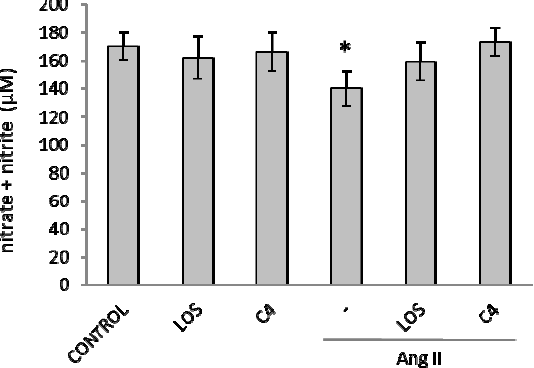
or with Ang II 5000 nM plus LOS or C4. Data are reported as mean ± SD (standard deviation)